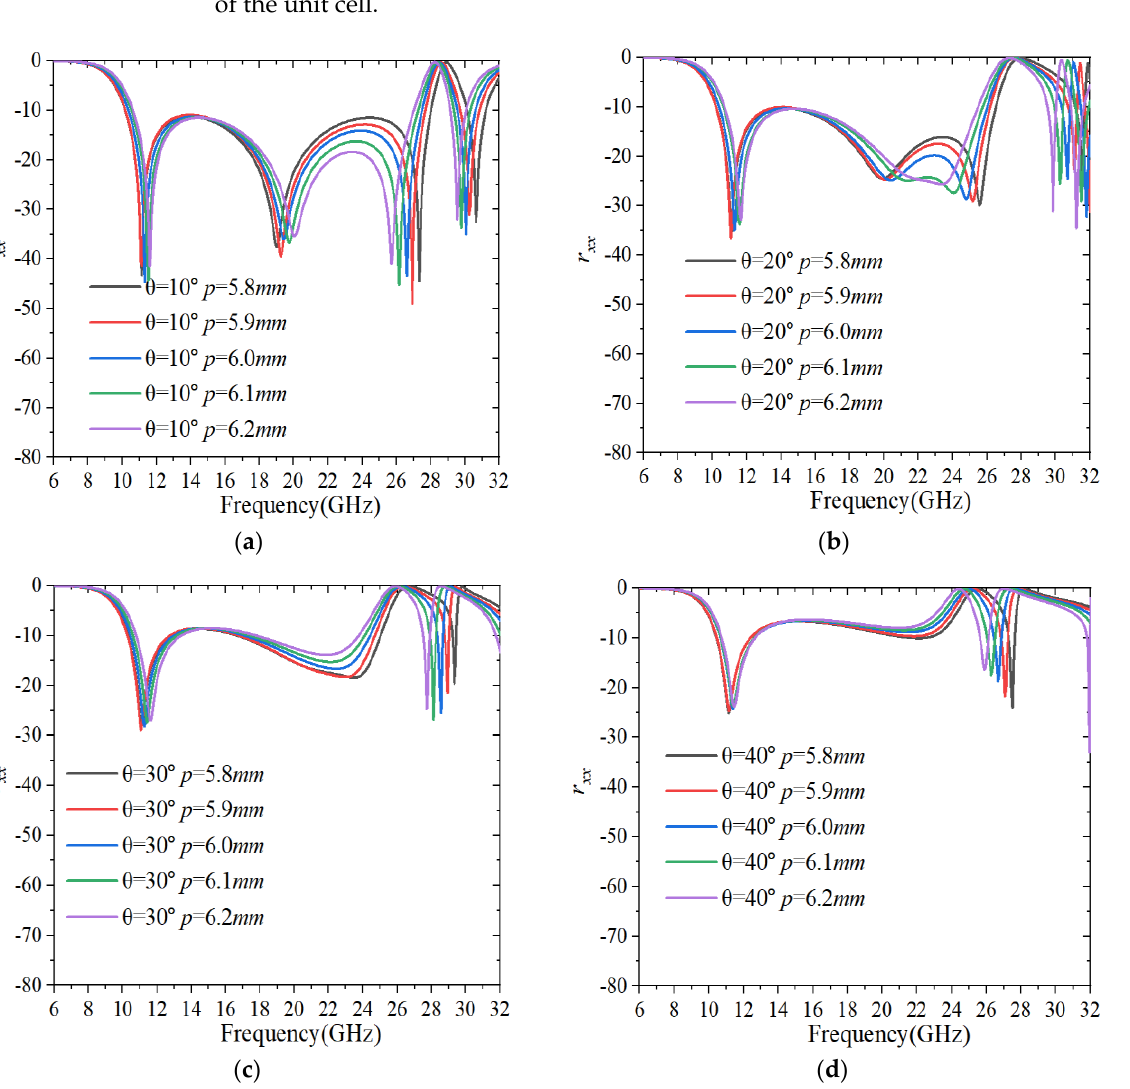
Figure 5. The PCR under different oblique incidences for ( a ) x -polarized wave; ( b ) y -polarized wave.